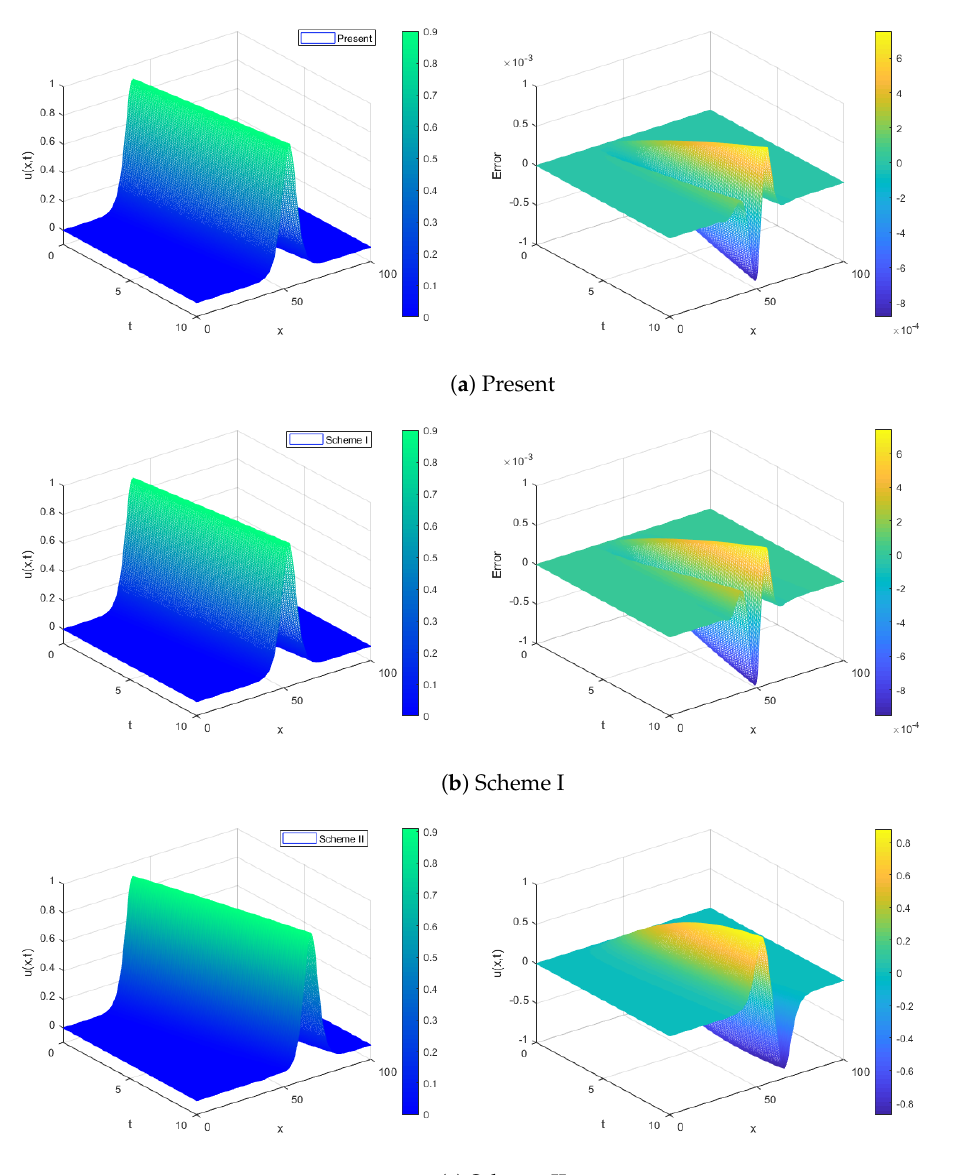
Figure 7. Numerical solutions and distribution errors with ∆ x = ∆ t = 1/8 and T = 0 to 10 ( a )